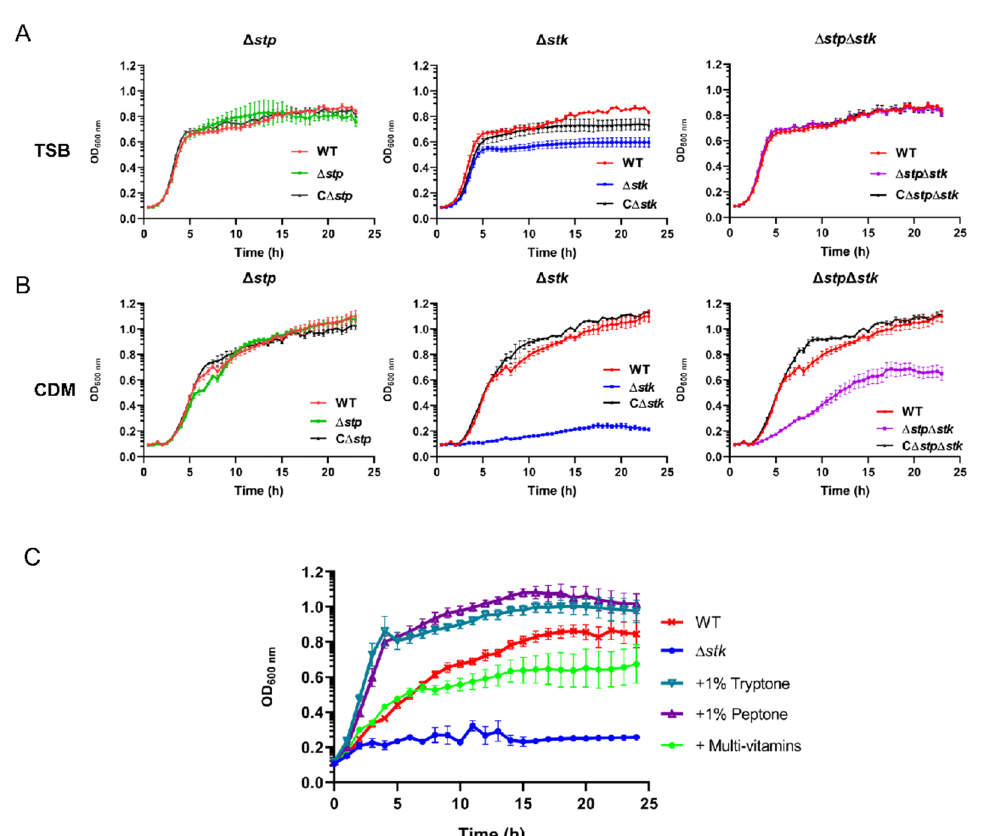
Figure 3. Growth analysis. Cells of the WT strain and each mutant grown overnight were inoculated in TSB medium ( A ) or CDM ( B ) with a similar initial OD 600 nm value. ( C ) The growth of WT strain in CDM and that of the ∆ stk strain in CDM or CDM supplemented with each indicated nutrient. Growth was monitored with an automatic plate reader with shaking at 37 °C. Data are presented as means ± SD of triplicate.